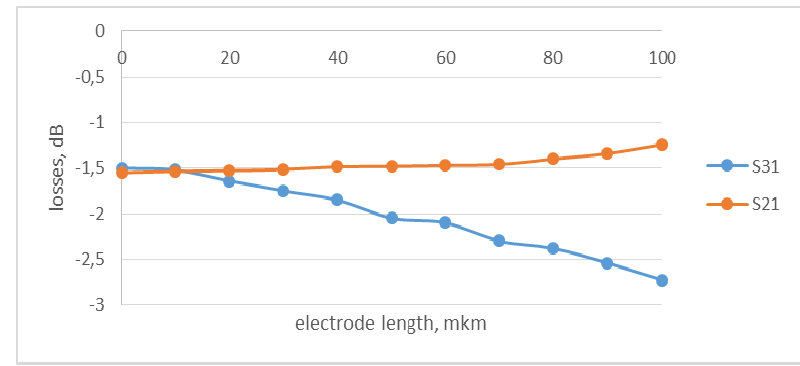
Fig. 4. The dependence of transfer coefficients from length of control electrode.